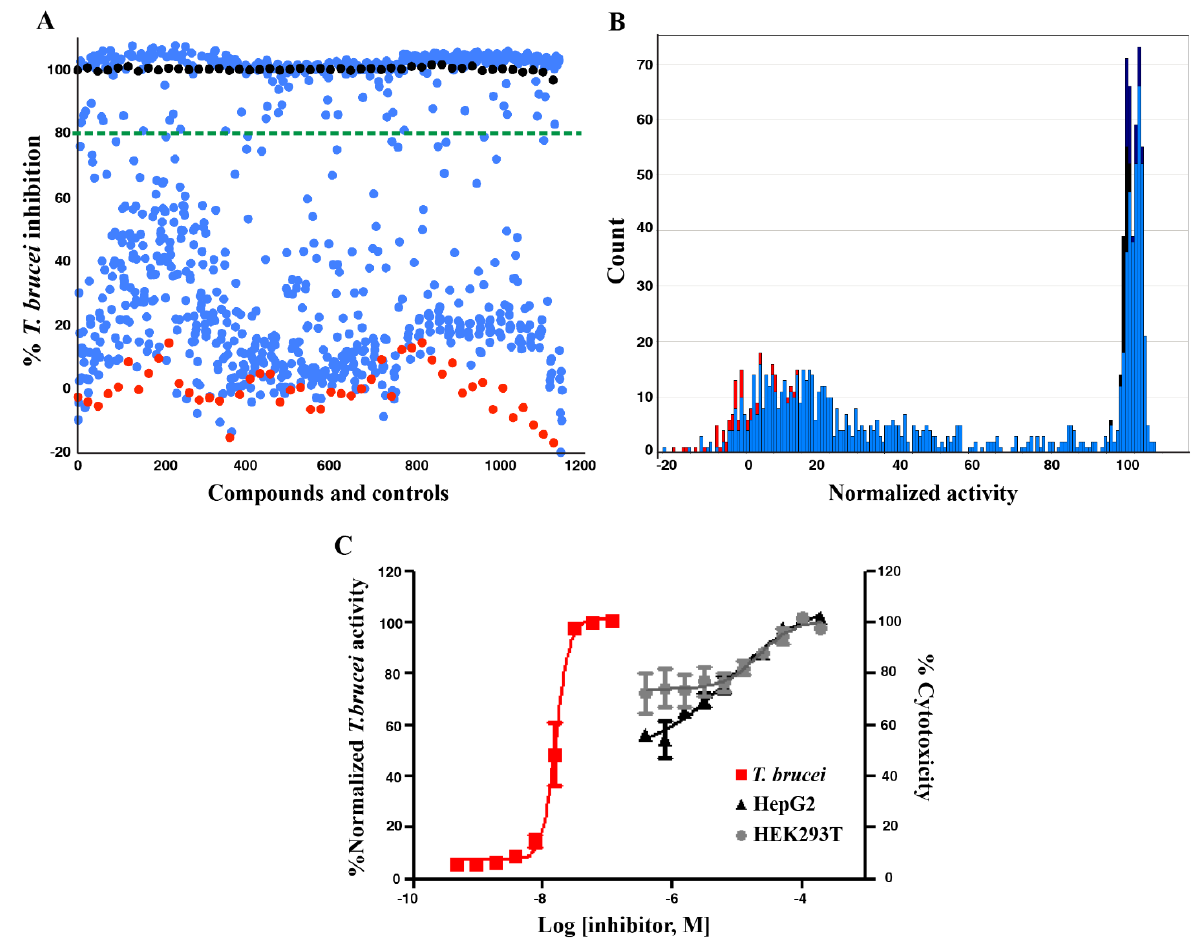
Figure 2. High throughput screening against T. brucei growth: ( A ) Distribution plot of the 861 natural compounds and extracts (blue), 0.5% DMSO (red), and pentamidine at EC (black); ( B ) Frequency distribution of the 861 natural compounds and extracts based on binned normalized activity; ( C ) Dose response curve of pentamidine against T. brucei , HEK293T, and HepG2